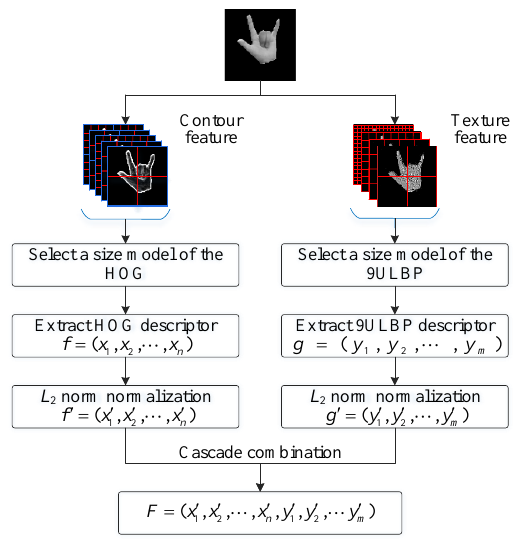
Figure 10. Feature fusion